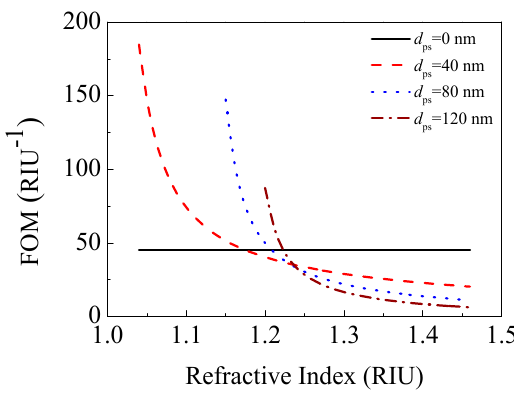
Figure 9. FOM versus the refractive index of porous silica film with various thicknesses. In Figure 9, except for the FOM curve for d ps = 0 nm (traditional SPR sensor used for comparison), other FOM curves all go up with the decreasing of the refractive index of porous silica